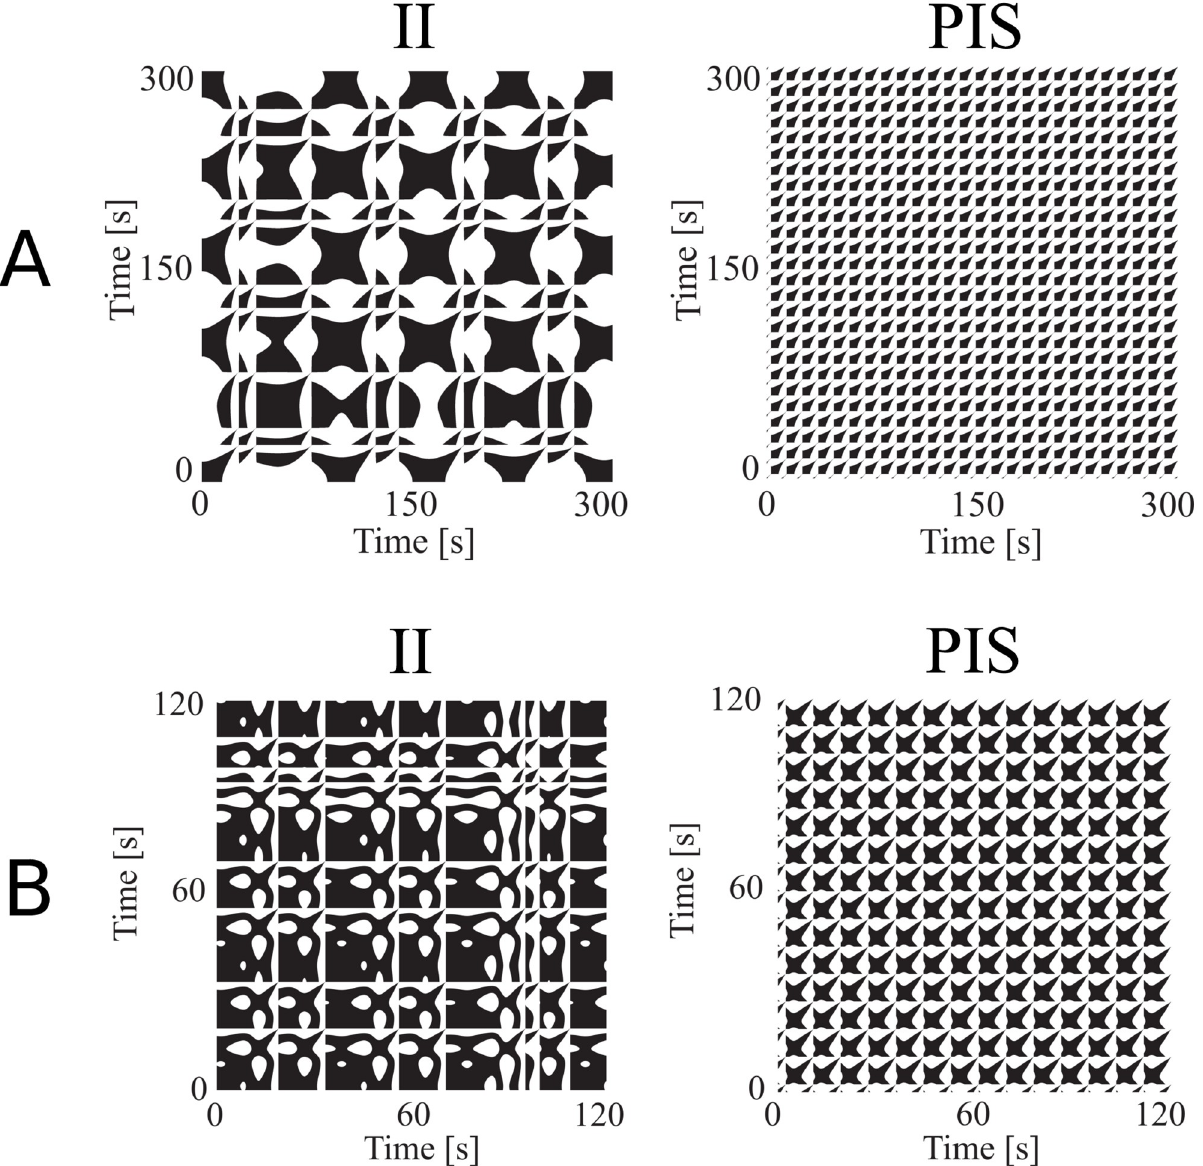
Fig 10. Recurrence plots for the simulated neuron dynamic models. A) Hindmarsh-Rose model considering a time window which represents a 1:3 firing ratio; B) Recurrence plots for the Izhikevich model considering a time window which represents a 2:3 firing ratio. Note that the II pattern presents larger but less frequent repeating structures, whereas PIS presents smaller but more frequent ones, as seen in Fig 6.